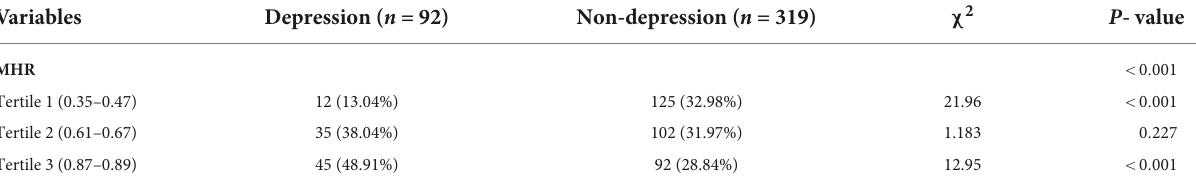
TABLE 3 MHR tertiles of patients.